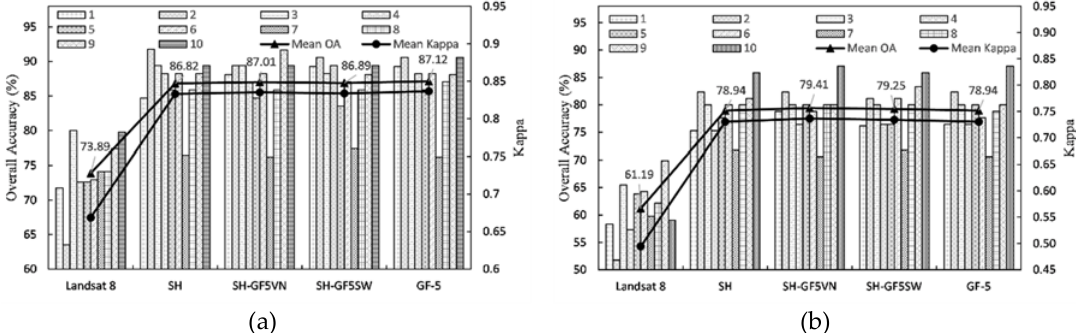
Figure 3. The overall accuracy of mangrove species mapping using Random Forests ( a ) and Support Vector Machine (SVM) ( b ) with different datasets and ten different groups of training and testing samples (number 1 ‐ 10) through stratified random sampling with proportion of 70% and 30% respectively; the mean Overall Accuracy (OA) and mean Kappa coefficient were also shown in lines. Table 5. The T-test of simulated Hyperion and